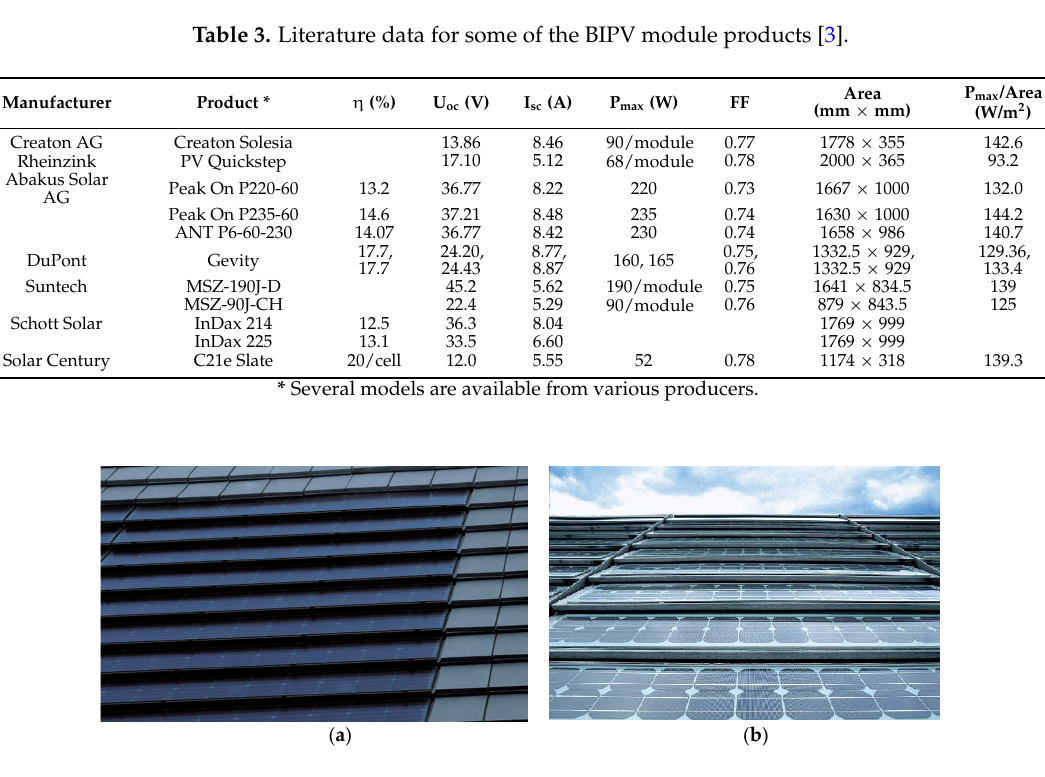
Figure 5. Example of BIPV module products from Creaton AG ( a ) [24] and Rheinzink ( b ) [25].